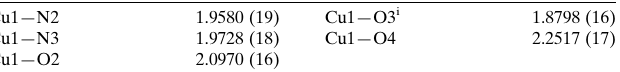
Selected bond lengths (A˚ ).